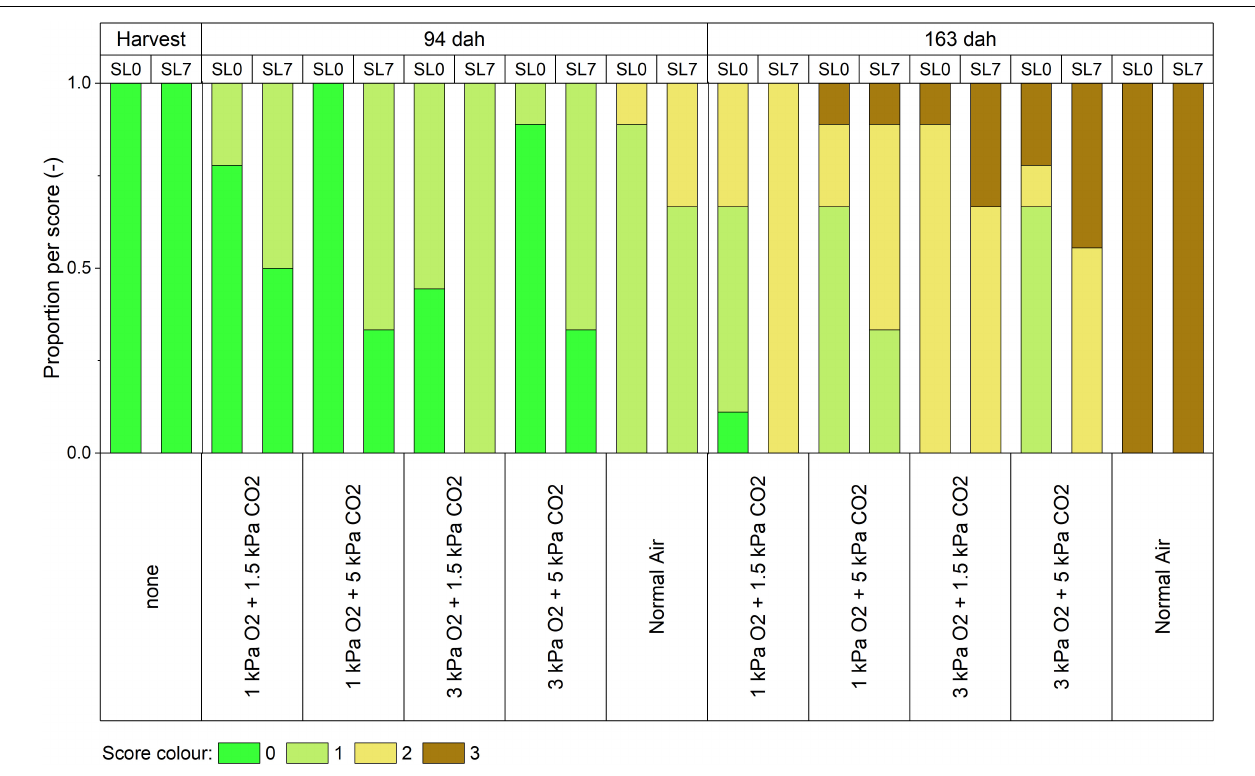
FIGURE 3 | External quality evolution of pointed cabbages during storage and shelf life. The outer leaves of nine biological replicates were scored at harvest, 94 dah and 163 dah in different atmospheric conditions on the day of opening the containers (shelf life zero days, “SL0”) and after 7 days on the shelf at 7 ◦ C (“SL7”). The leaves obtained a score according to the scale presented in Supplementary Figure 1 . The p -values per factor of the ordinal logistic regression are presented in Table 1 .